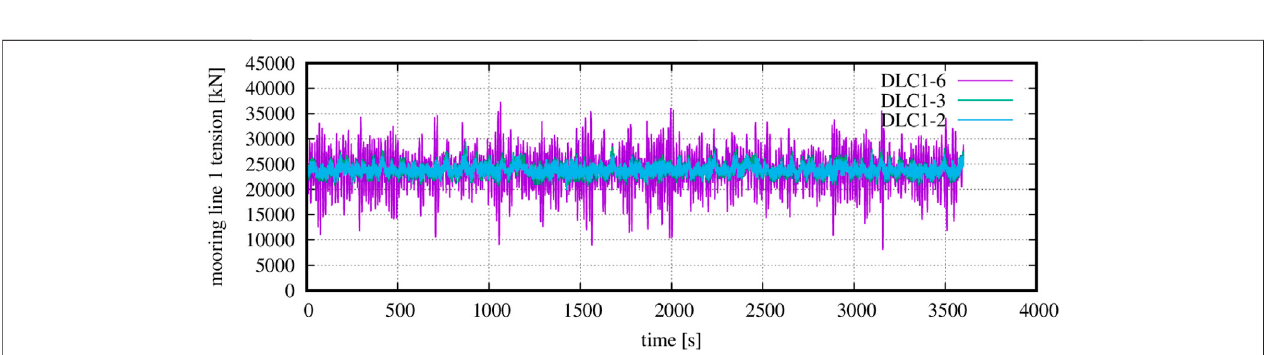
Frontiers in Energy Research |